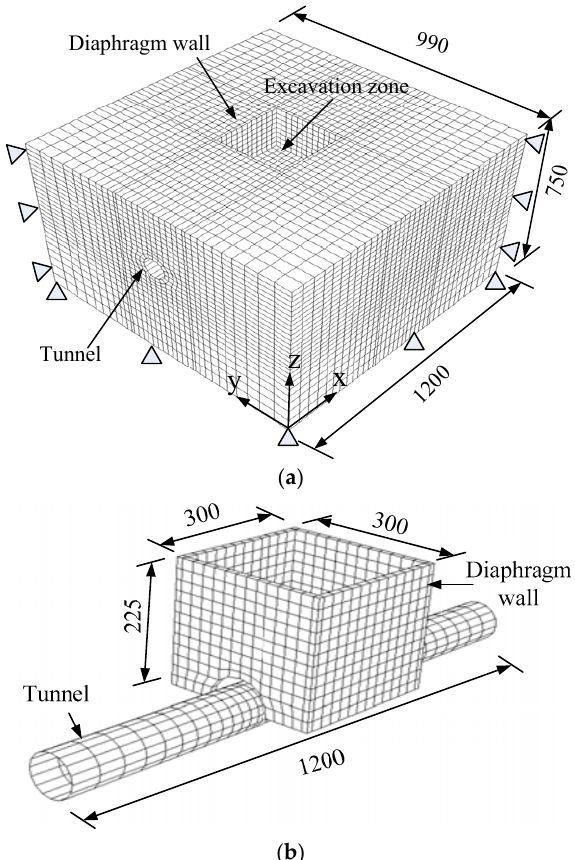
Figure 3. ( a ) Three-dimensional finite element model in model scale (mm) and ( b ) intersection of tunnel and diaphragm wall.